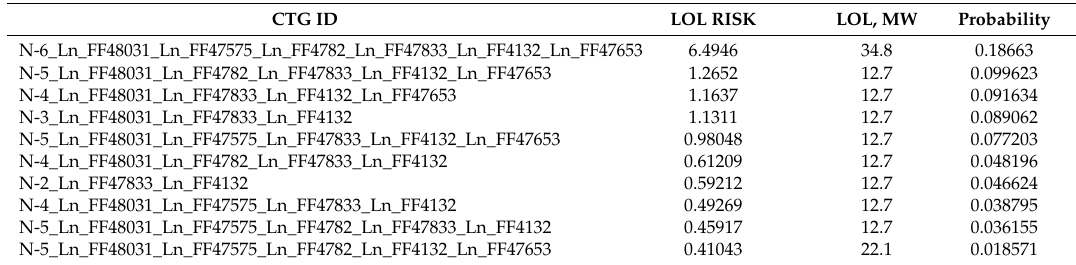
Table 5. Top 10 positions in the probability ranked list of contingencies – hour 15.